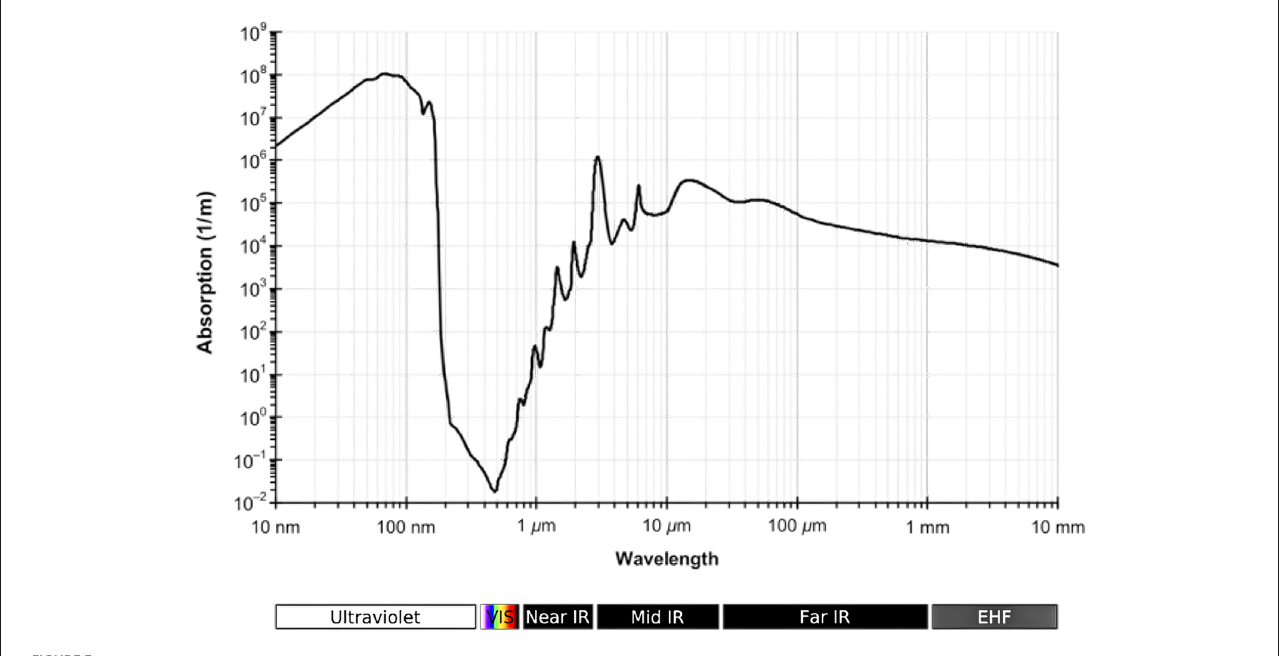
FIGURE3 Absorption spectrum of liquid water (Kebes,